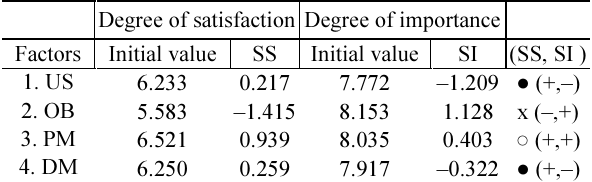
Table 4. Example of the response from the IRM questionnaire Factor j